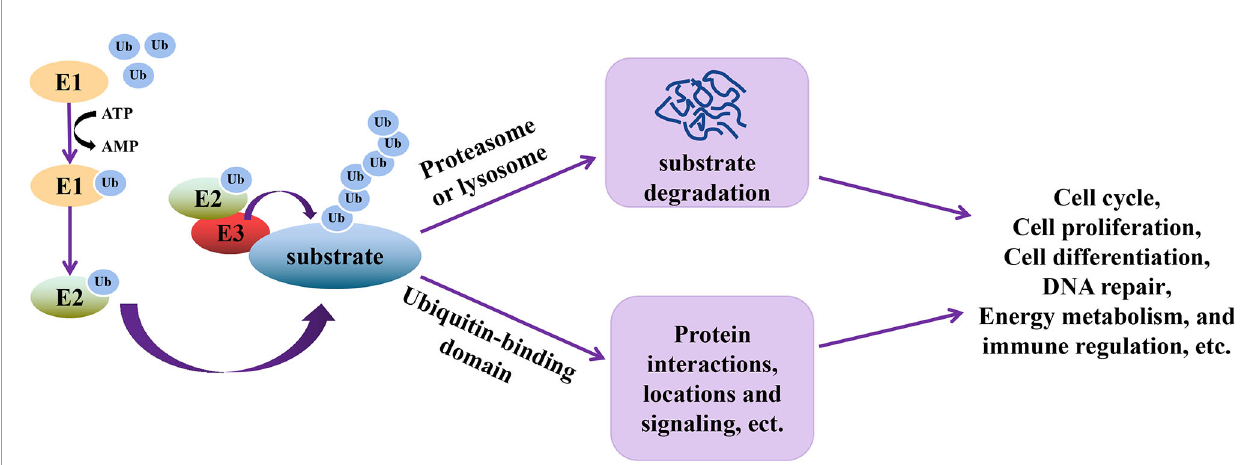
FIGURE 1 | Schematic representation of the functional relevance of ubiquitination. During ubiquitination, E1 is fi rst activated to transfer ubiquitin (Ub) to E2 using ATP. Through the interactions of E2 and E3, E3 and ubiquitinated substrates, Ub is transferred to the substrates, which allows the substrates to be recognized by enzyme complex or organelles. The ubiquitinated substrate can then perform multiple functions, including cell cycle, proliferation, differentiation, DNA repair, energy metabolism, signal transduction and immune regulation,